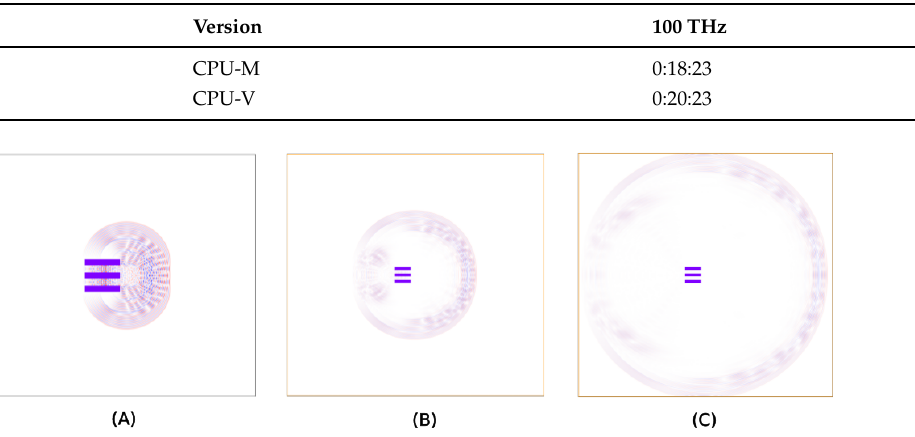
Figure 21. The nanowaveguide experiment’s electric field distribution ( E z ) is depicted. Snapshots at 500 ( A ), 1500 ( B ) and 3000 ( C ) time steps are shown. Table 18. Execution times obtained using the RTX 3060 and Titan RTX, expressed in mm:ss, for the open space propagation.